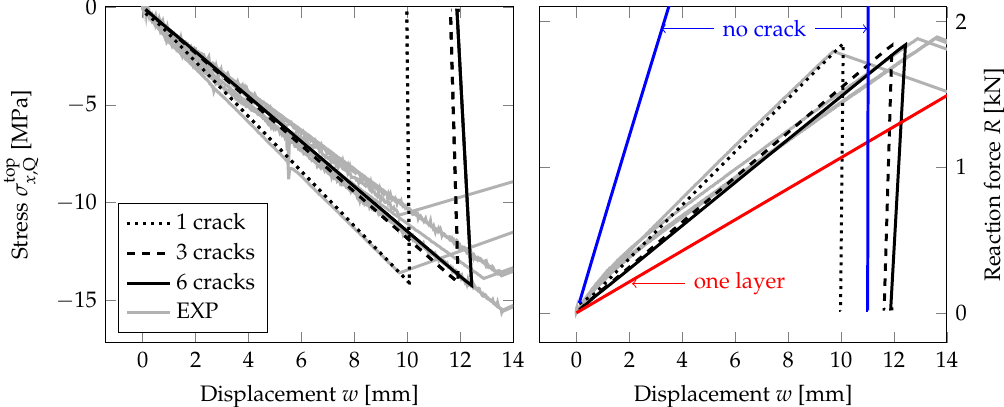
Figure 19. PF-P formulation, anisotropic staggered approach with the spectral-decomposition split, PS model: Evolution of the compressive stress at a quarter of midspan and the overall reaction under the loading points for the mid-span displacement for the second stage of loading and the EVA-based laminated glass plates. Experimental data (EXP, grey lines) and numerical response for one failure stress of 60 MPa (black) with different number of initial